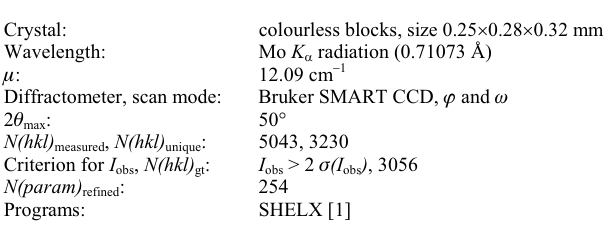
Table 1. Data collection and handling.